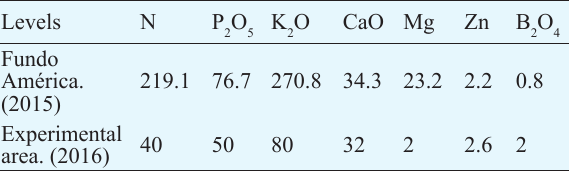
Table 1. Fertilization levels (kg ha−1) used in the farm and the experimental